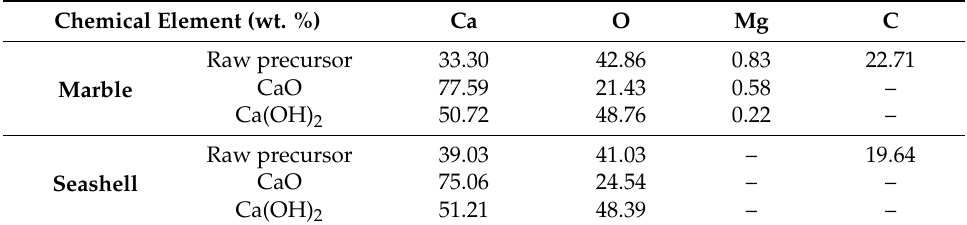
Table 2. XRF characterization of raw precursors and CaO, Ca(OH) 2 powders.